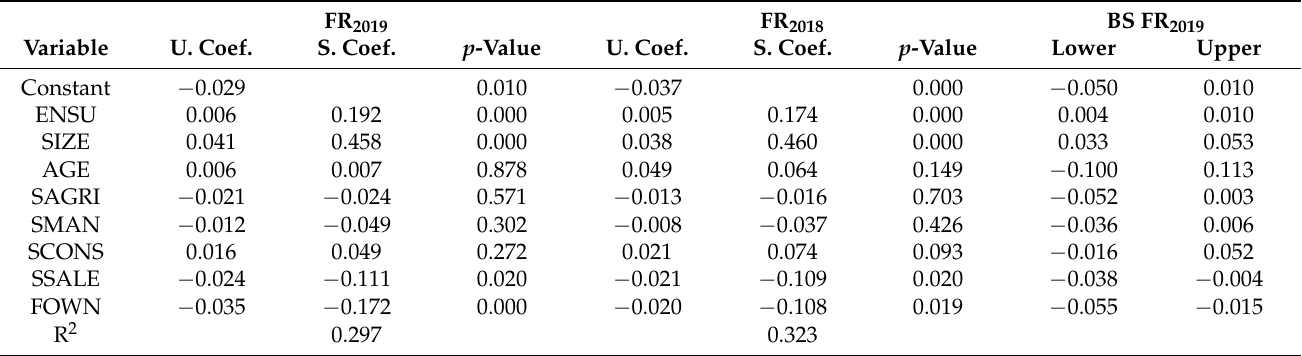
Table 5. Models with ENSU as the independent variable (N = 421).